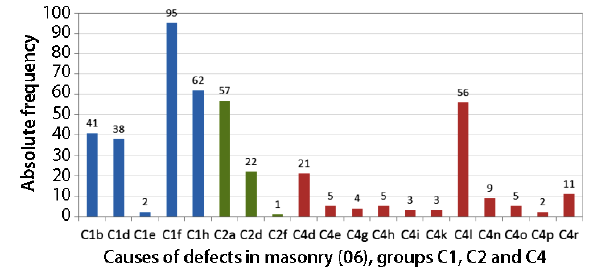
Fig. 15. Absolute frequency of defects according to the specific construction elements belonging to group 06 – masonry